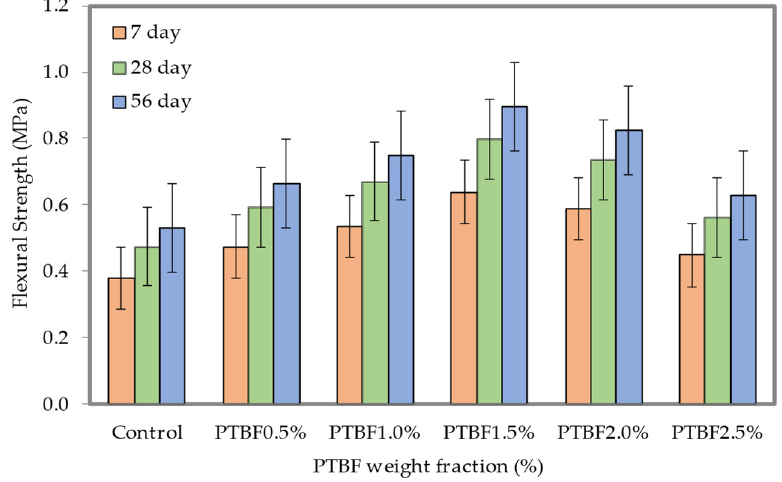
Figure 16. Flexural strength of 700 kg/m 3 density LFC with different weight fractions of PTBF.